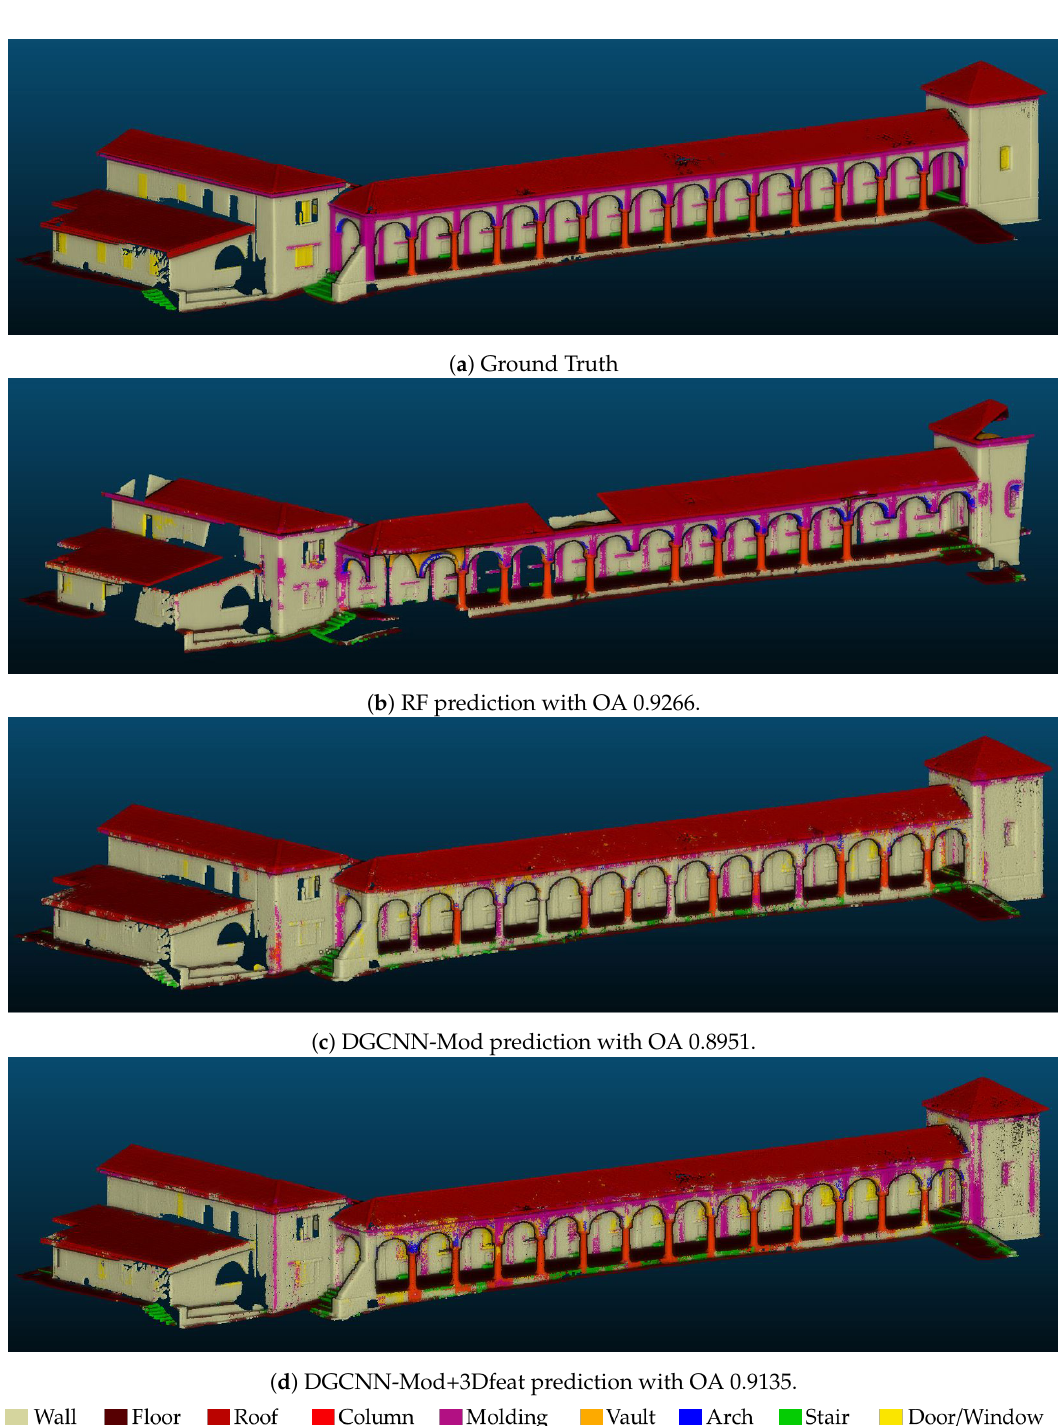
Figure 8. Ground Truth ( a ) and the best Predictions ( b – d ) of the SMG scene. Please note that the point clouds deriving from the DL approach are